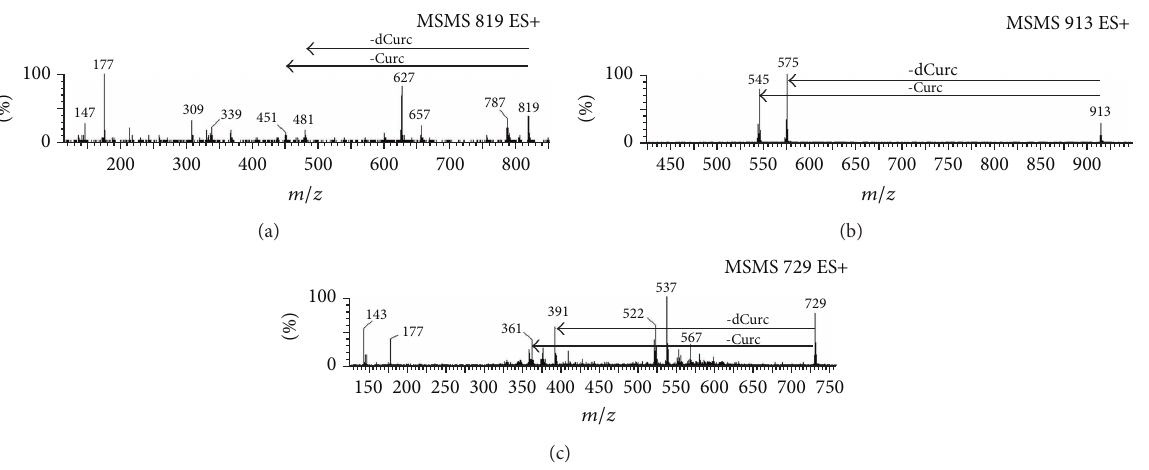
Figure 1: CID-MS/MS spectra of ions [dCurc + Curc-H + Cd] + ((a) CE = 30V), [dCurc + Curc-H + Pb] + ((b) CE = 15V) and [dCurc + Curc-H + Mg] + ((c) CE = 35